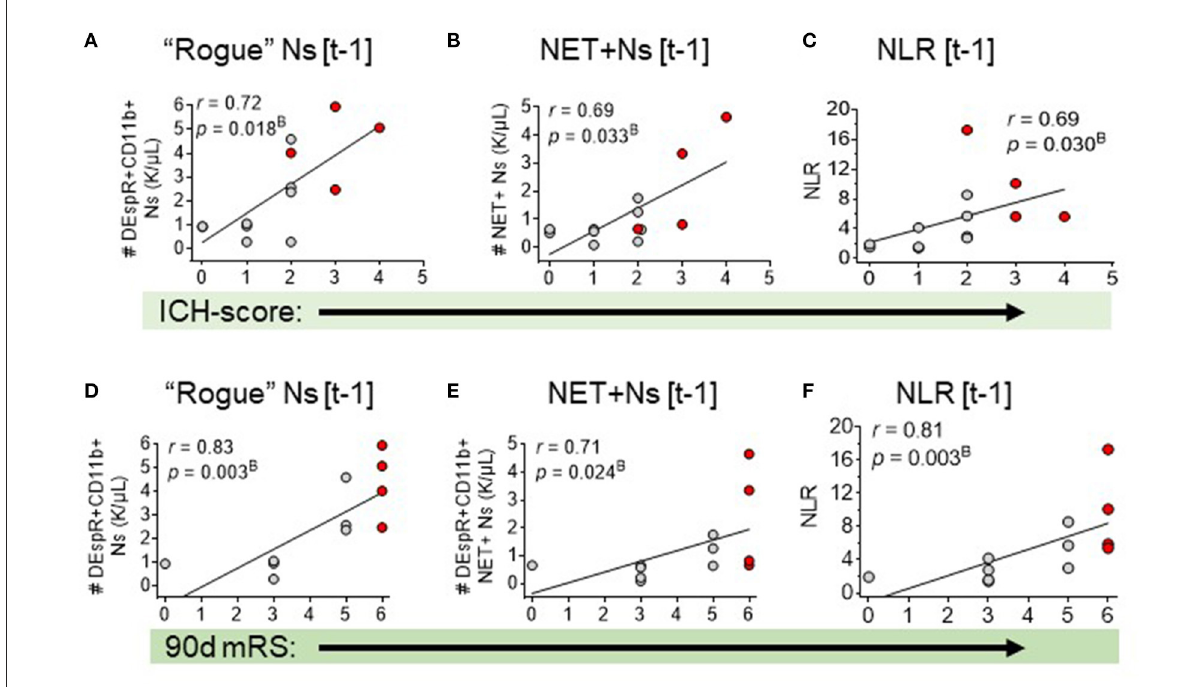
FIGURE3 Spearman rank correlation analysis of three neutrophil-based markers and sICH outcomes: admission ICH score and 90-day mRS. Correlation of admission ICH score with: (A) DEspR + CD11b + neutrophil counts, K/ µ l, (“rogue” Ns [t-1]), (B) NET-forming neutrophil counts, K/ µ l, (NET + Ns [t-1], and (C) neutrophil-lymphocyte ratio (NLR). Correlation of 90-day mRS with: (D) DEspR + CD11b + neutrophil counts (“rogue” Ns [t-1]), (E) NET-forming Ns (NET + Ns [t-1], (F) neutrophil lymphocyte ratio (NLR). [t-1], on day of flow cytometry; Red • symbols represent sICH-subject non-survivors; gray • symbols mark values for sICH-subject survivors; r , Spearman rank correlation coefficient; and p B , p -value with Bonferroni